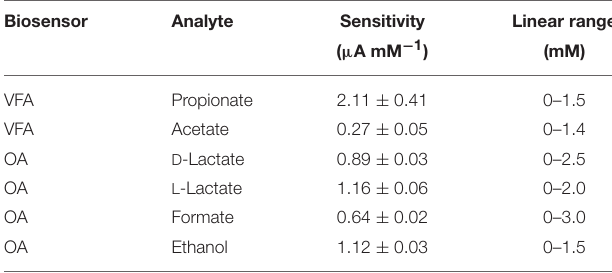
TABLE 1 | Sensor characteristics of the volatile fatty acid (VFA) and organic acid (OA) biosensor operated at an applied potential of + 0.6 and + 0.3 V vs. Ag/AgCl,